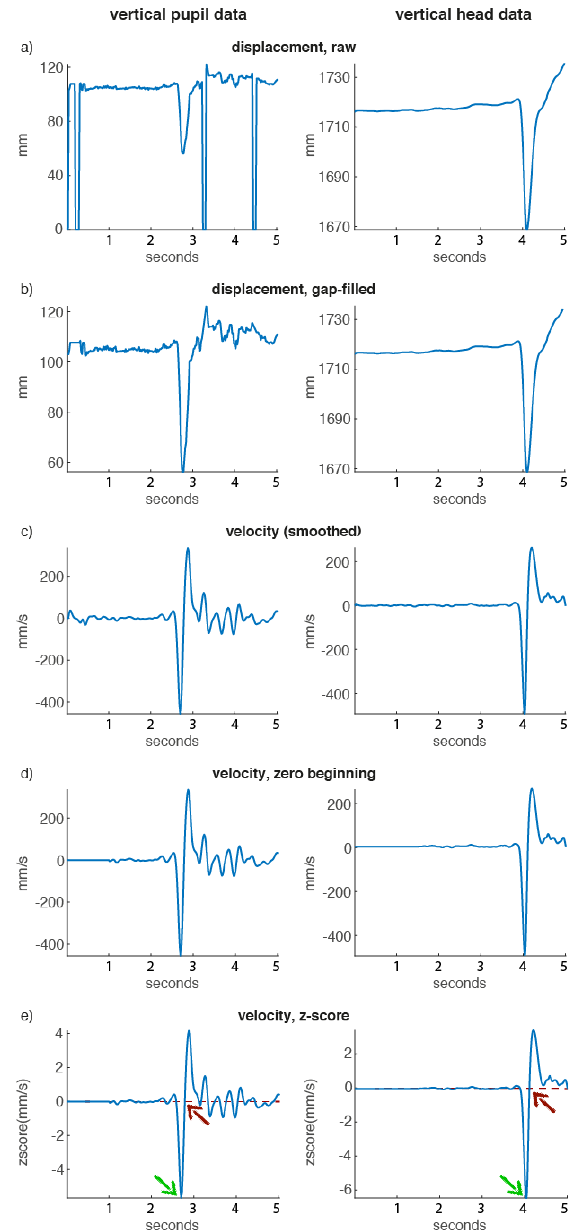
Figure 4. Workflow of the synchronization procedure. a) vertical displacement of pupil and left front head marker; b) linearly gap- filled data; c) vertical velocity data; d) first 1.5 sec of mocap and first sec of pupil data set to 0; e) z-scored data plus indicating peak-picking of velocity minima of the nod (green arrows) and subsequent zero-crossing (red arrows) used to align eye and mocap data.